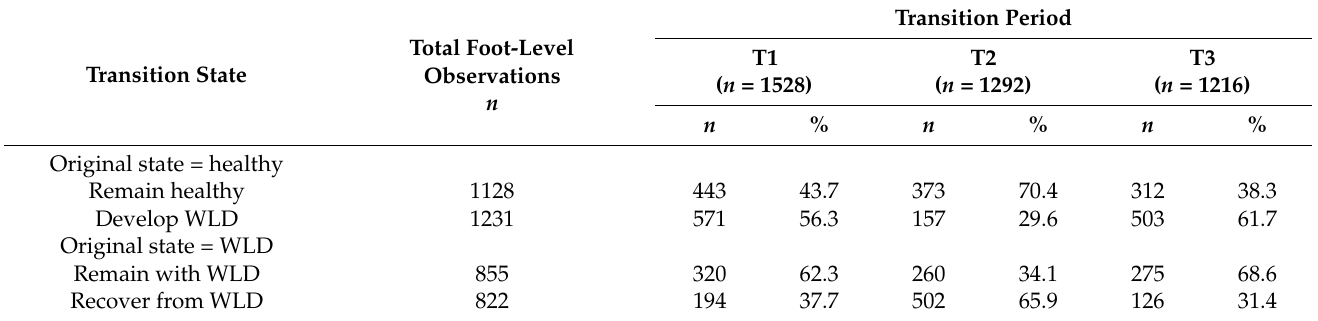
Table 8. Distribution of white line disease transition states across three transition periods for 4036 foot-level observations of 400